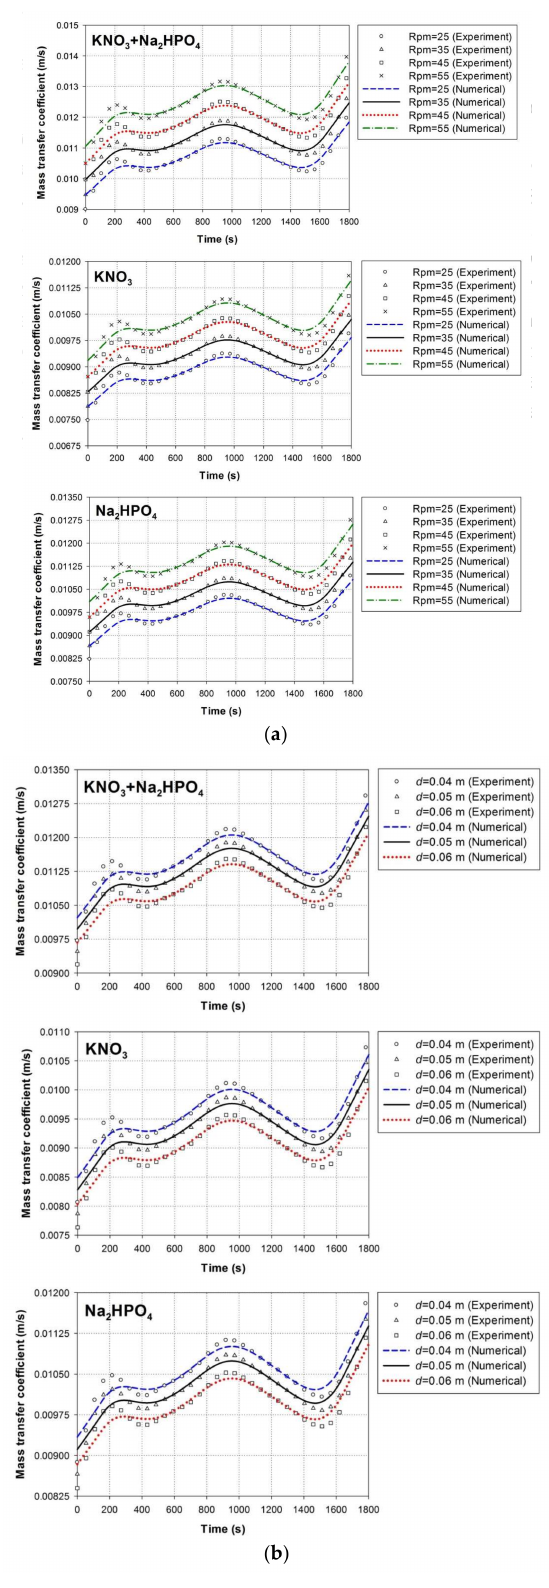
Figure 3. Comparison of the experimental and numerical results of solid–liquid mass transfer coefficient with the effects of different ( a ) paddle wheel speeds and ( b ) water